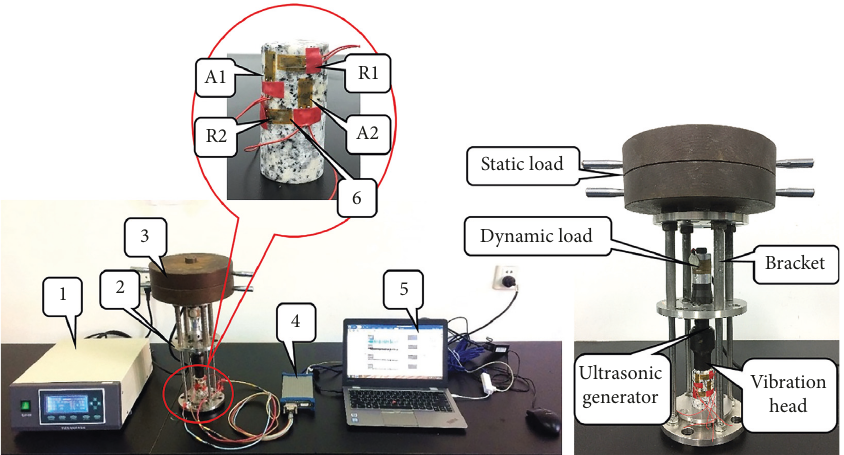
Figure 3: Ultrasonic vibration test. (a) Ultrasonic vibration and strain testing equipment. (b) Loading method.